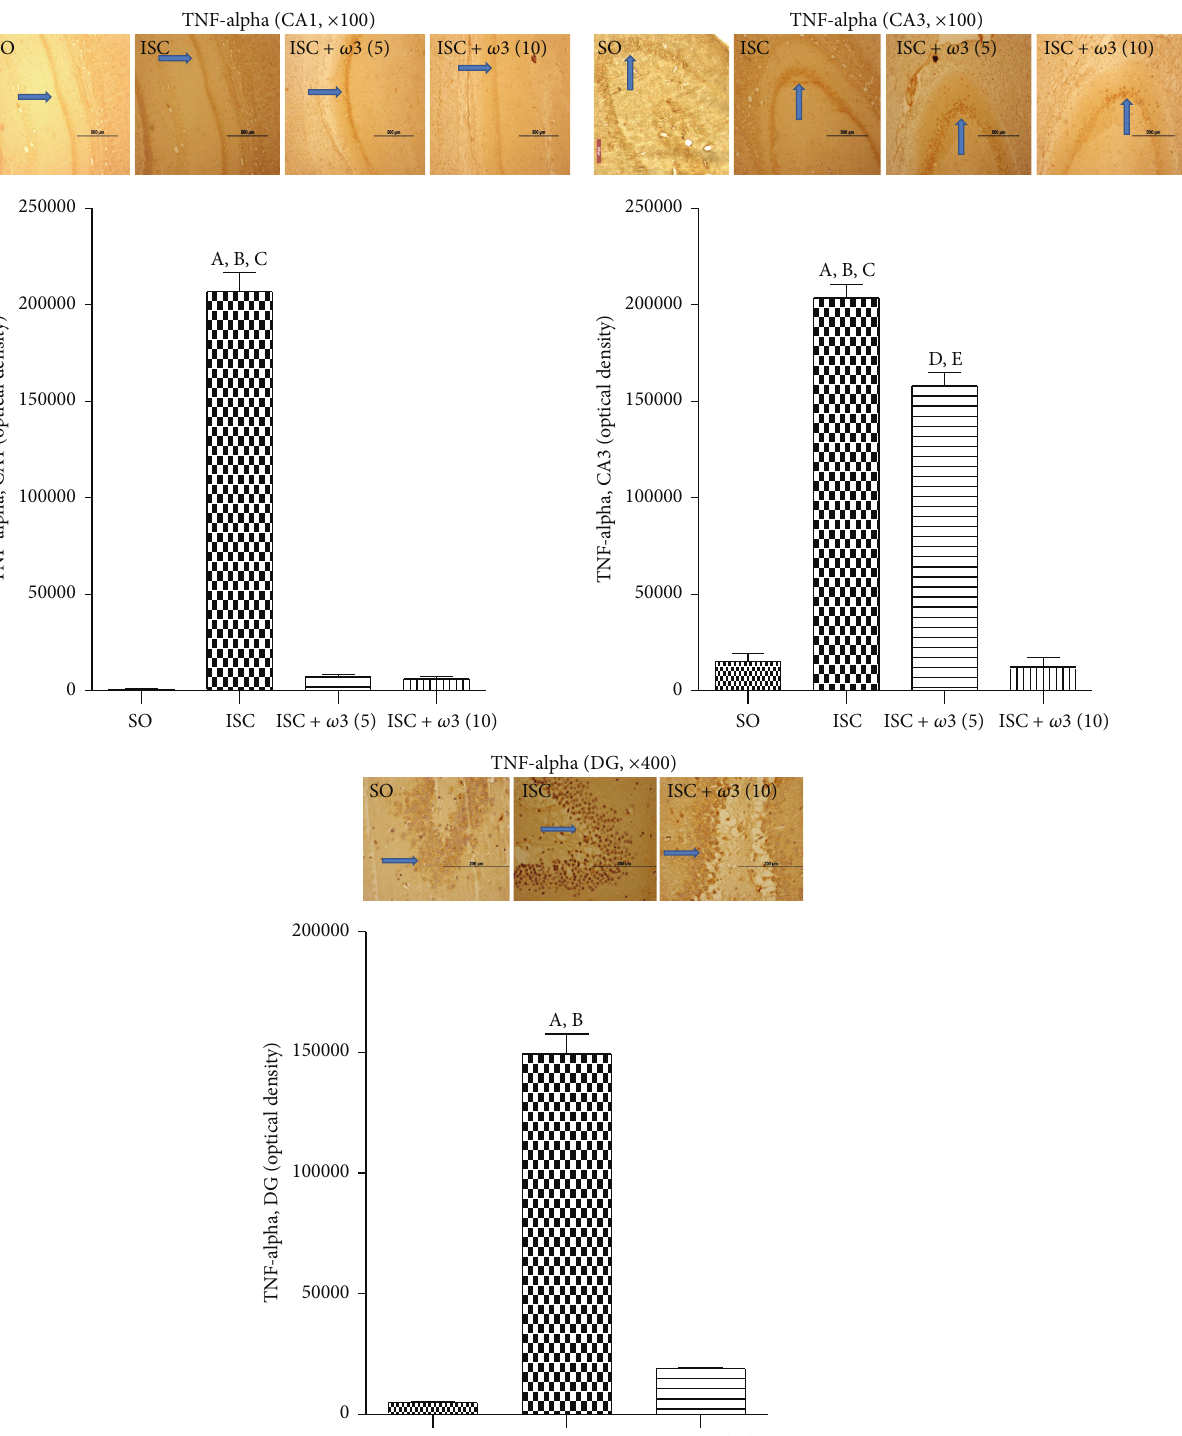
Figure 6: 𝜔 3 treatments of ischemic animals (3 animals per group) reduced the immunostaining for TNF-alpha, mainly in CA1 and CA3 hippocampal subfields and in the dentate gyrus (DG). Representative photomicrographs and quantitative measurements performed with the Image J software from 3 to 5 fields. The groups are SO, untreated ischemic (ISC) and ischemic after 𝜔 3 treatments (5 and 10mg/kg, 7 days). CA1: (A) versus SO, q = 41.76 ∗∗∗ ; (B) versus ISC + 𝜔 3 (5), q = 40.44 ∗∗∗ ; (C) versus ISC + 𝜔 3 (10), q = 40.63 ∗∗∗ . CA3: (A) versus SO, q = 32.86 ∗∗∗ ; (B) versus ISC + 𝜔 3 (5), q = 7.494 ∗∗∗ ; (C) versus ISC + 𝜔 3 (10), q = 33.31 ∗∗∗ ; (D) versus SO, q = 7.494 ∗∗∗ ; (E) versus ISC + 𝜔 3 (10), q = 23.91 ∗∗∗ . DG: (A) versus SO, q = 30.26 ∗∗∗ ; (B) versus ISC + 𝜔 3 (10), q = 27.34 ∗∗∗ (one-way ANOVA and Newman-Keuls test as the post hoc